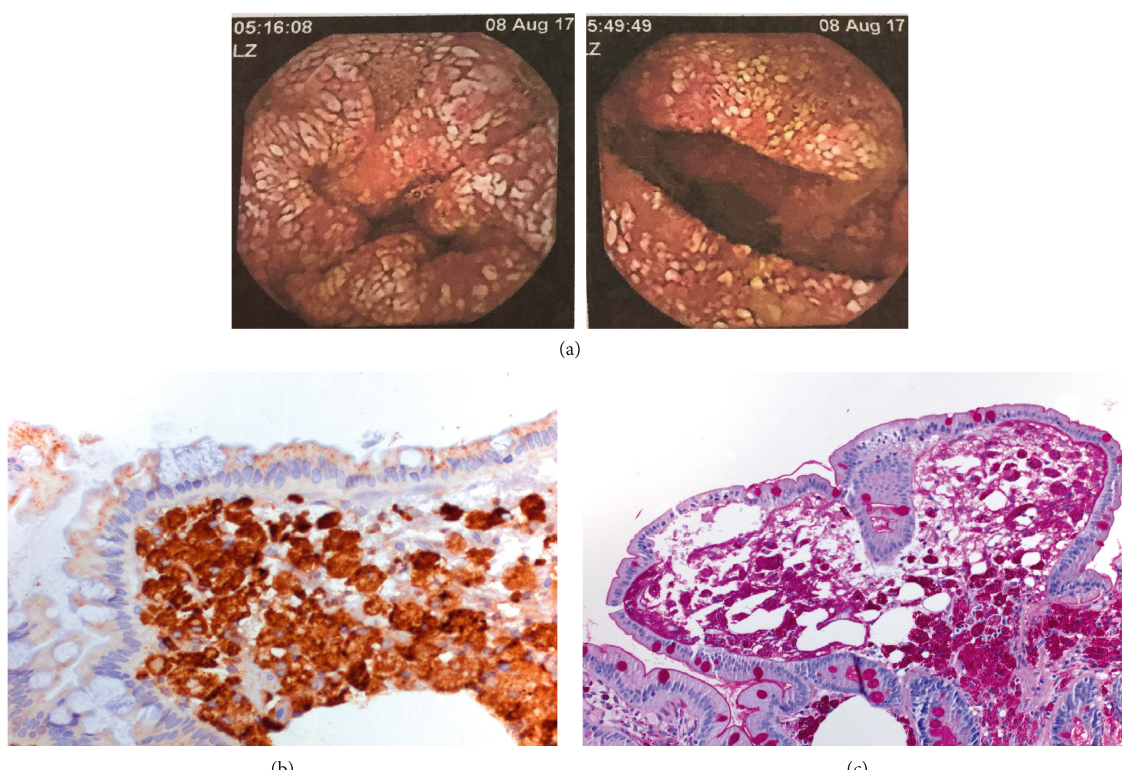
Figure 1: Macroscopic and microscopic descriptions of WD in case number 1. (a) Intestinal lipodystrophy in duodenum. (b) CD68 positive for macrophage-duodenal biopsy. (c) PAS-positive granules-duodenal biopsy. Body temperature 34.53535.53636.53737.53838.539 Antimicrobial therapy °C